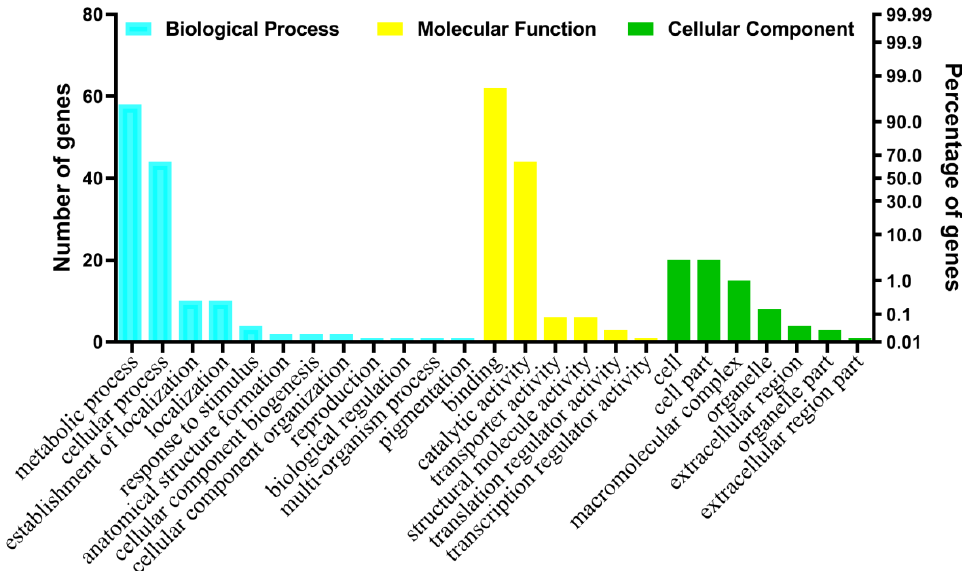
Figure 2. Functional classification of S. avenae -induced ESTs in tetraploid wheat seedlings identified from suppression subtractive hybridization library (SSH). Classification of ESTs based on biological process, cellular components and molecular function using Blast2GO software (http://blast2go.org) (accessed on 26 August 2021).